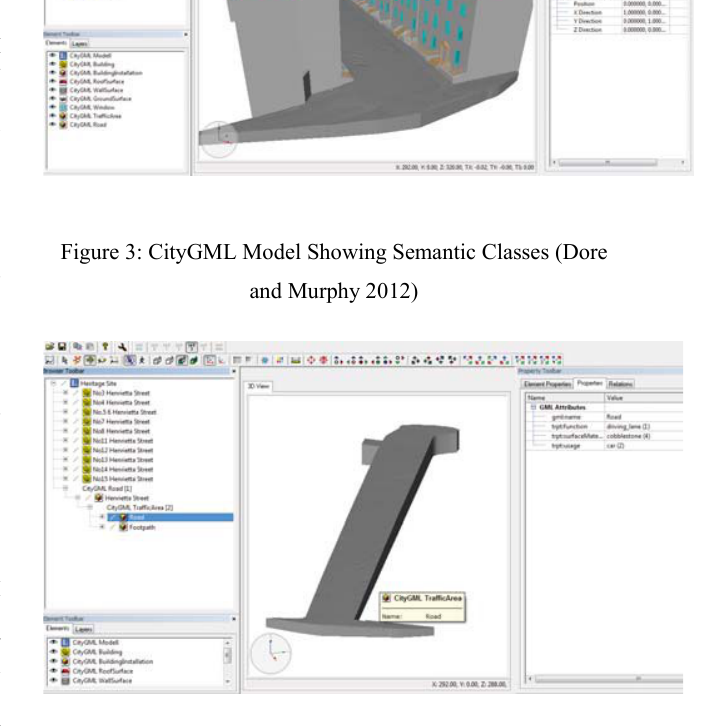
Figure 4: Road Feature Class Showing Associated Attributes (Dore and Murphy 2012)